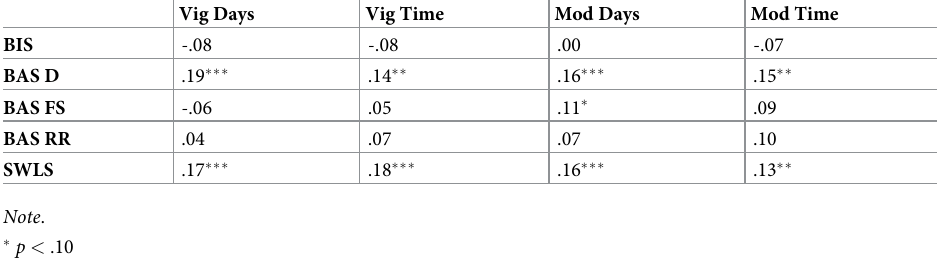
Table 16. Correlations of BIS/BAS and SWLS with exercise variables (Study 3).